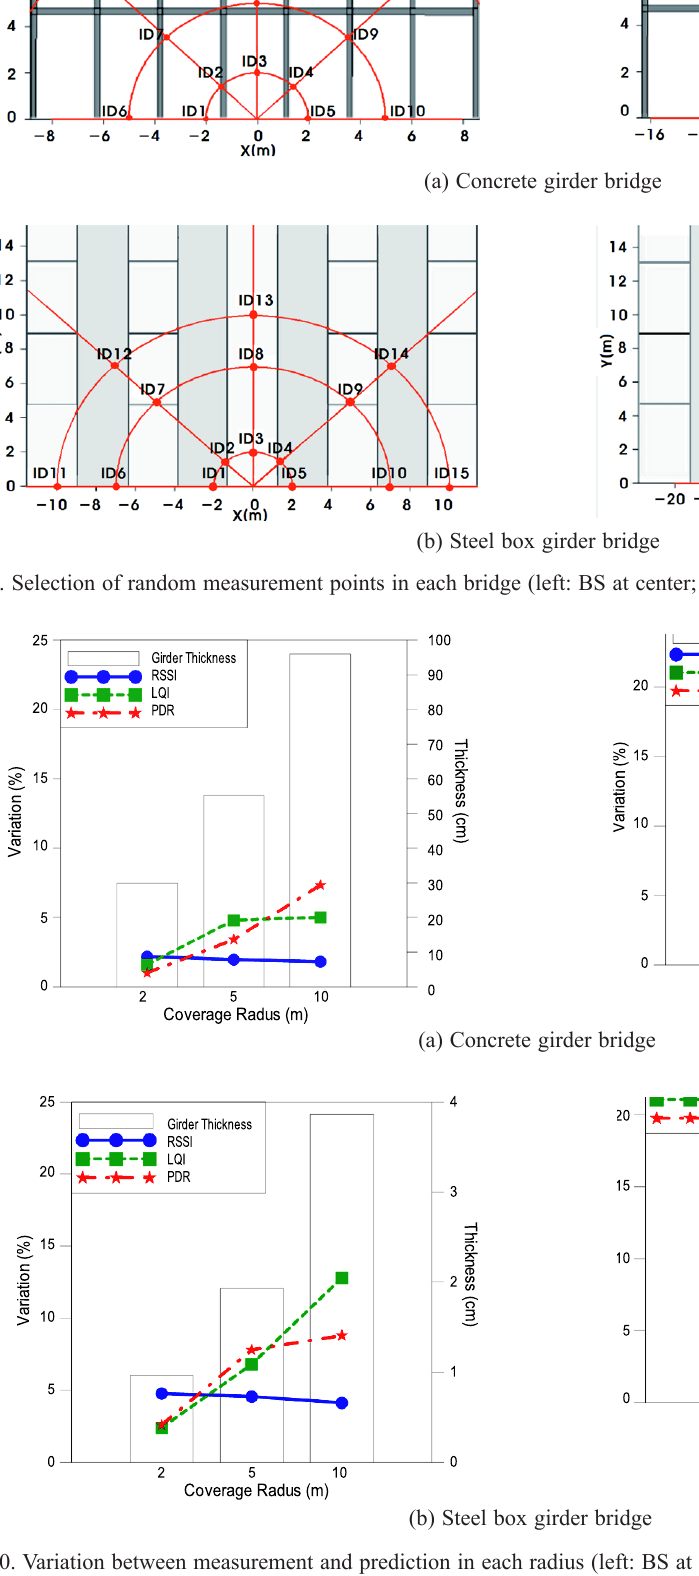
Fig. 10. Variation between measurement and prediction in each radius (left: BS at center; and right: BS